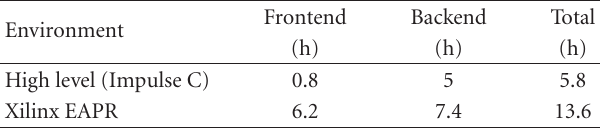
Table 4: Coprocessor application productivity benchmarks.